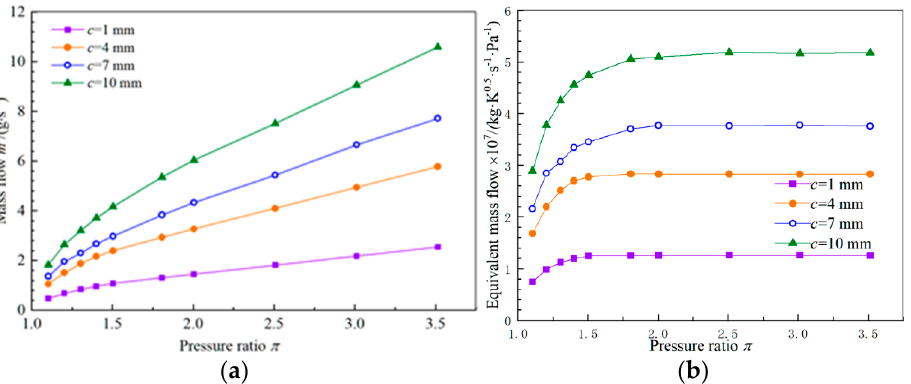
Figure 10. Experimental results of total leakage and equivalent mass flow of total leakage under different sheet spacing ( a = 1.0 mm). ( a ) Total leakage against the pressure ratio. ( b ) Equivalent mass flow of total leakage against the pressure ratio. Table 4. The range of total leakage (a = 1.0 mm).